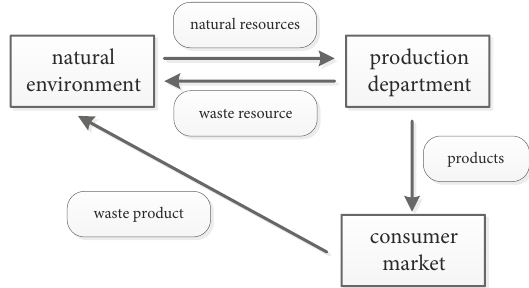
Figure 3. Traditional economic production model